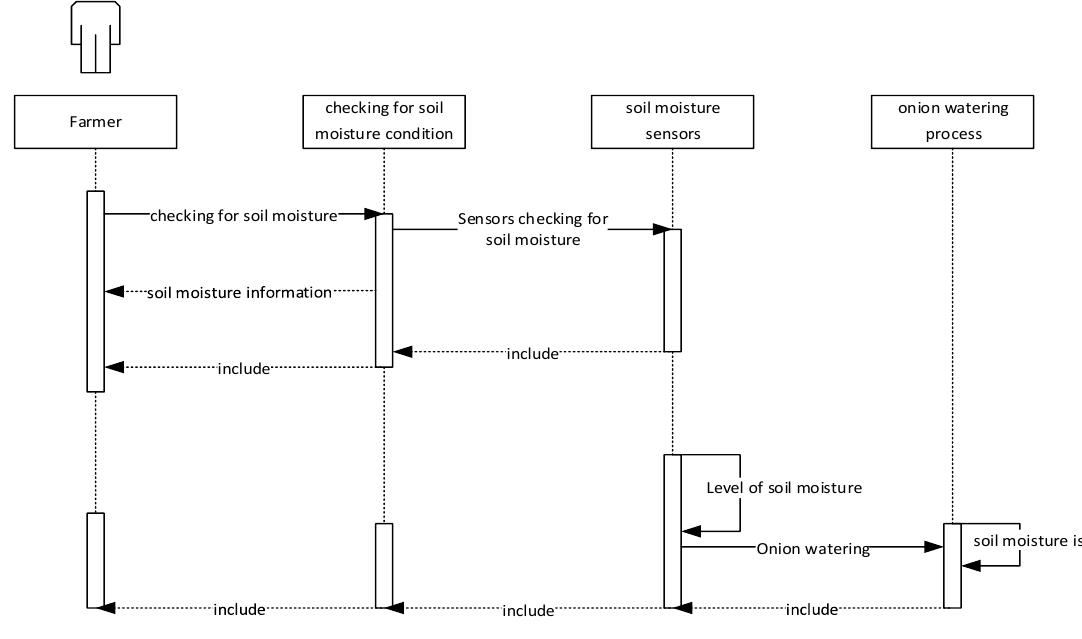
Figure 3. Watering Sequence Diagram.